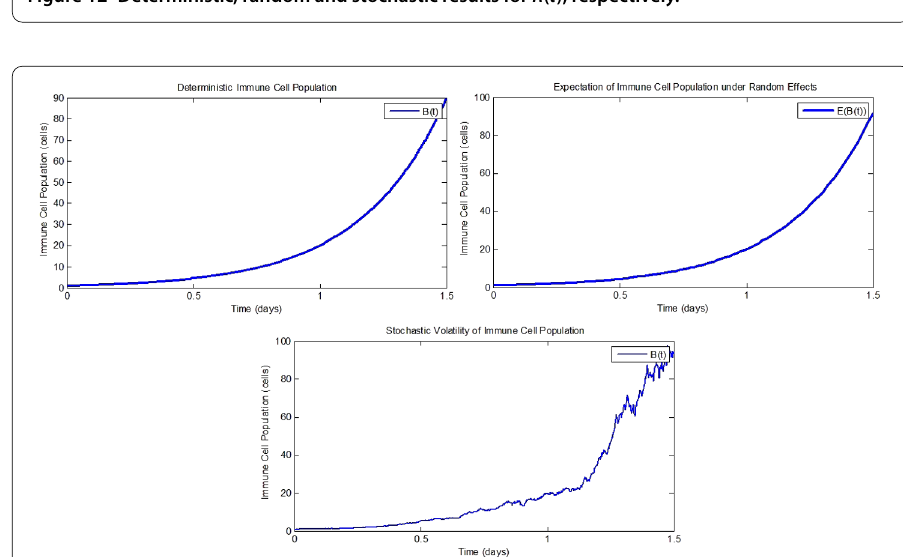
Figure 12 Deterministic, random and stochastic results for R ( t ), respectively.